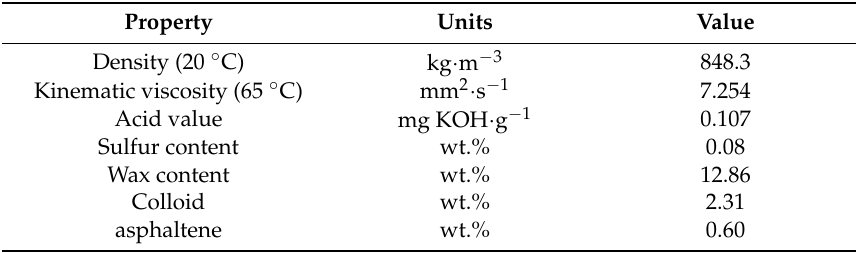
Table 2. Composition properties of crude